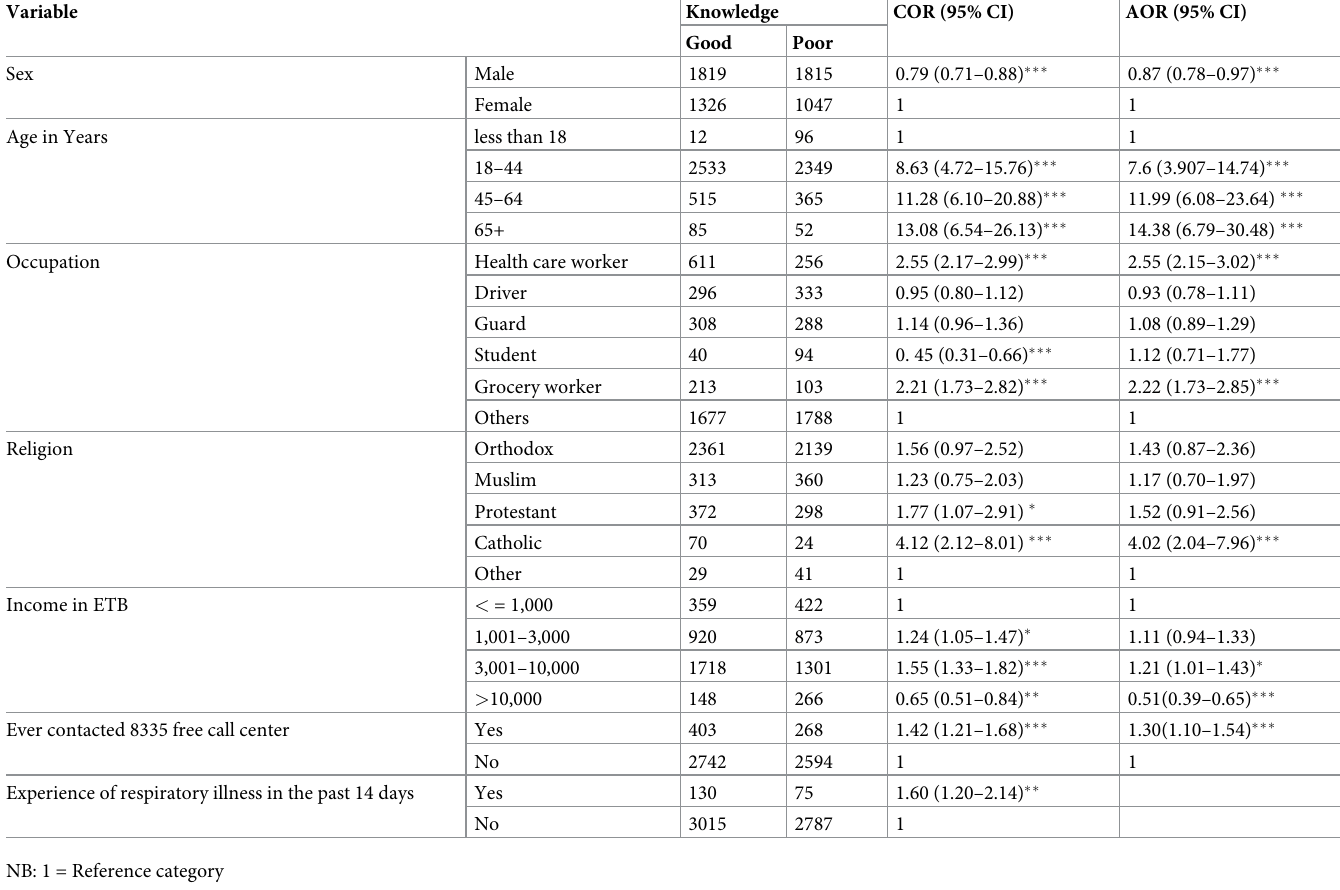
Table 3. Factors associated with knowledge on the transmission of COVID 19 among participants, Addis Ababa, Ethiopia, 2020.